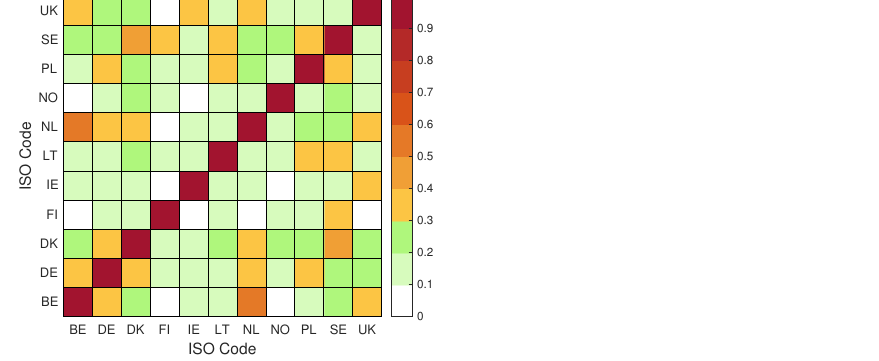
Figure 7. Correlation coefficients of Dunkelflaute occurrences between eleven European